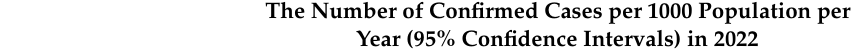
Table 3. The association of booster vaccination rate with the number of confirmed COVID-19 cases per year for the United States and Japan.